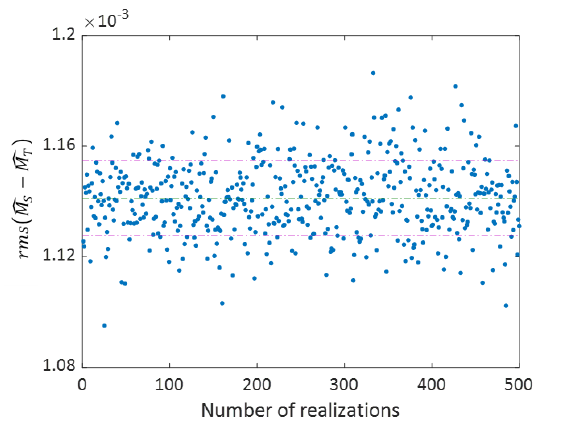
Fig. 2. Differences of rms (Eq. (2)) of air as a sample using 500 realizations of a numerical simulation, utilizing the Moore- Penrose pseudo-inverse strategy ( (cid:2) =0.01).